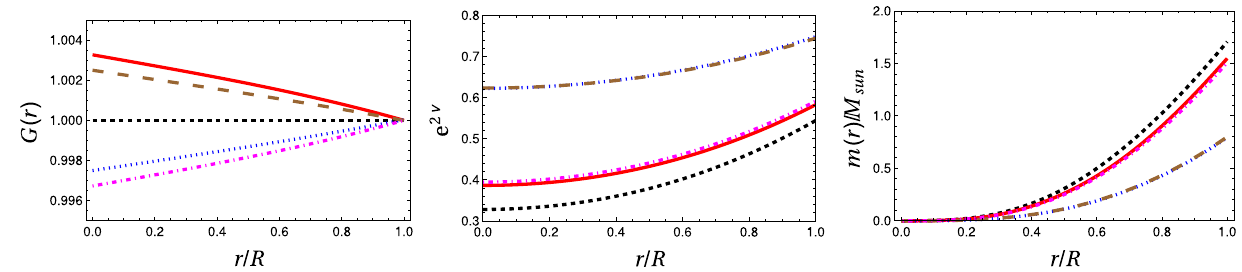
Fig. 1 Five interior solutions assuming a linear EoS and B = 60 MeV / fm 3 . Shown are the quantities of interest versus normalized radial coordinate r / R . For the initial conditions see Table 1 and text. First case (dashed black line) corresponds to GR. LEFT: Gravitation